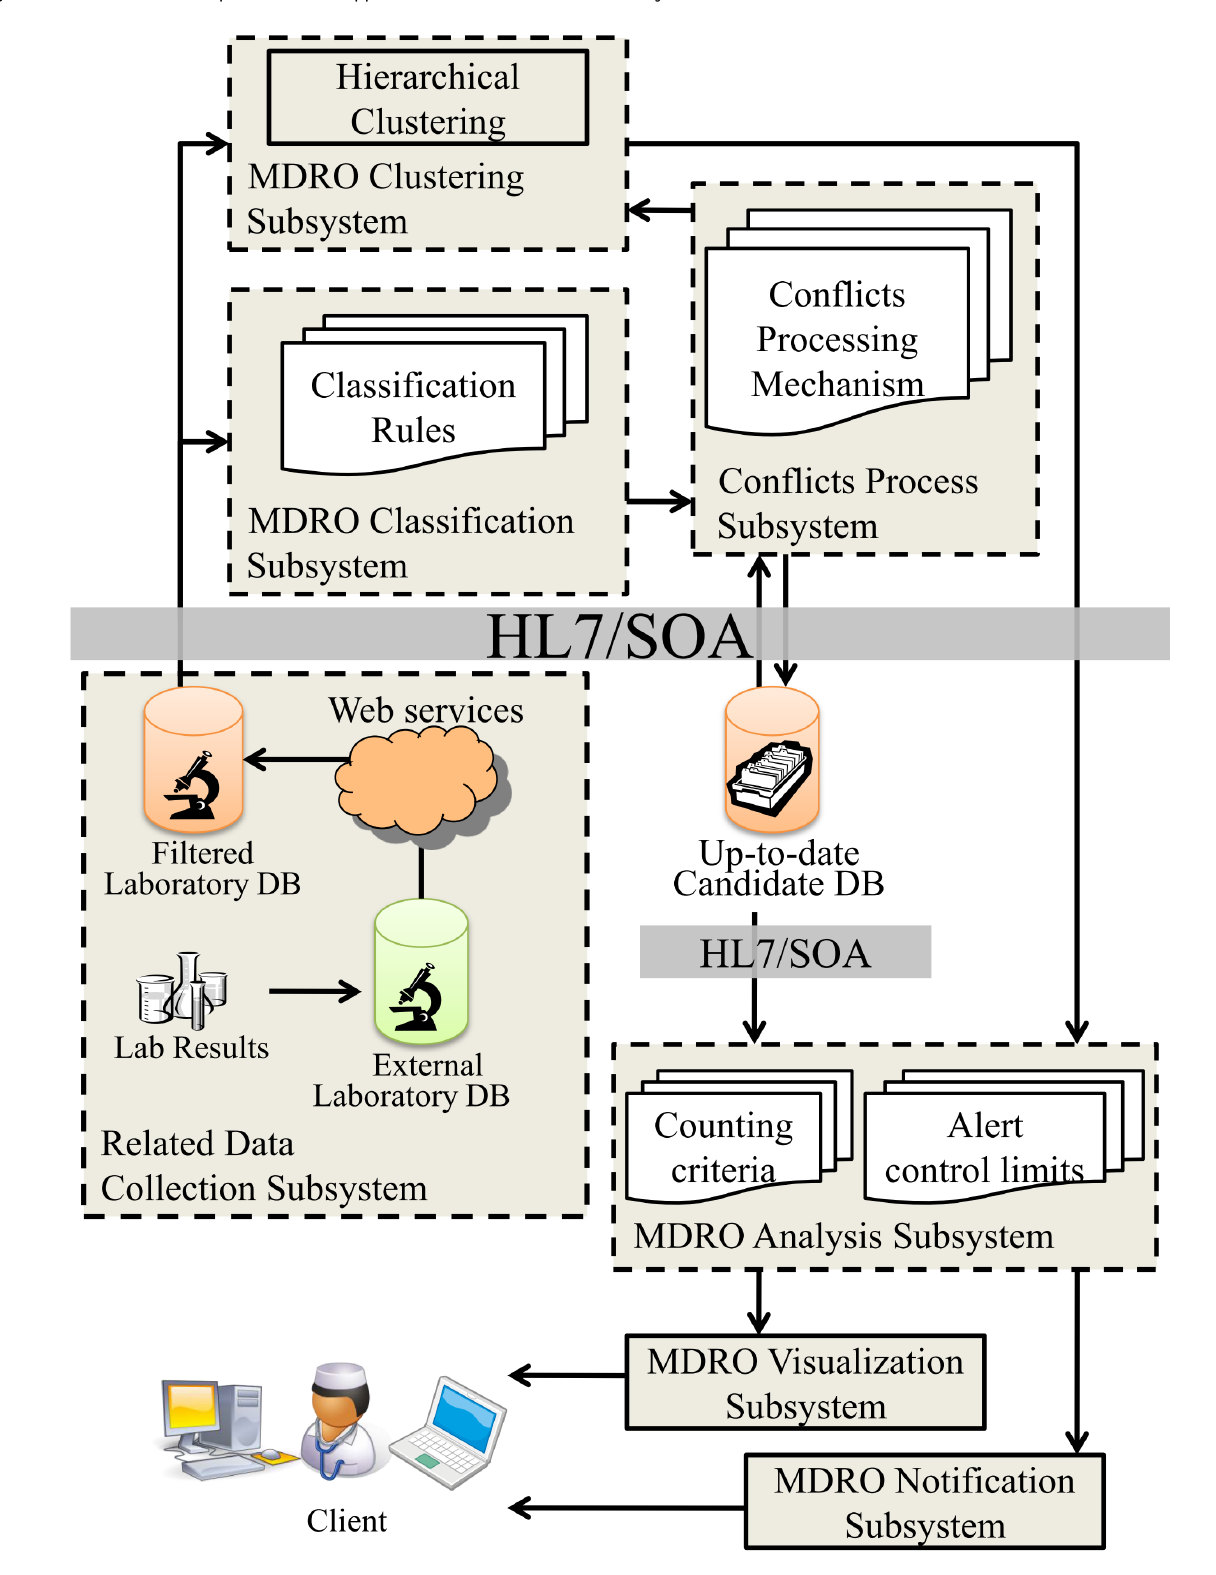
Figure 2. The software components of the application module consist of 7